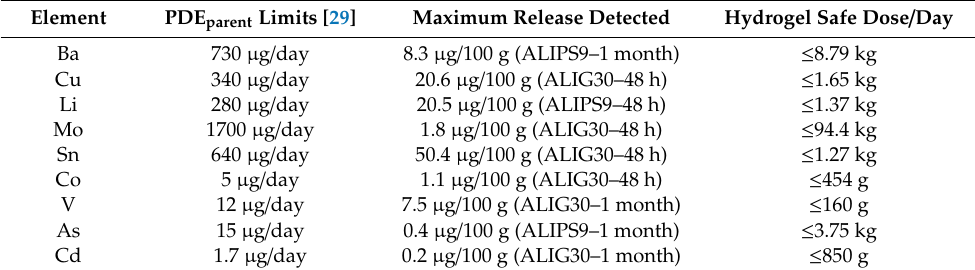
Table 4. Theoretical safe doses of ALIPS9 and ALIG30 hydrogels based on elements with defined parenteral Permitted Daily Exposure (PDE) levels. Calculations have been made by using the higher mobility value reported by Franz cells (either ALIPS9 or ALIG30). Additionally, safety doses are calculated assuming a theoretical dermal bioavailability of